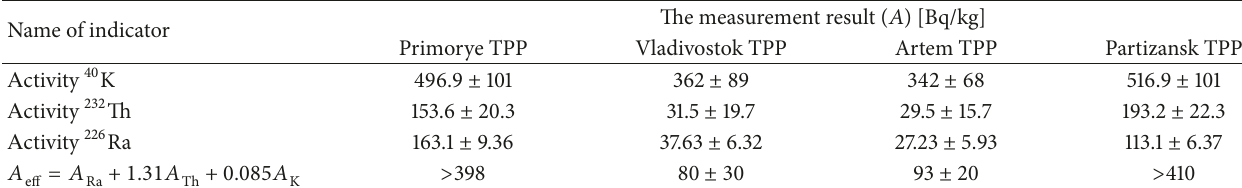
Figure 2: The Vladivostok TPP’s fly ash micrographs: (a) × 200; (b) × 2000. Table 3: Specific effective activity of fly ash depending on the composition [19].